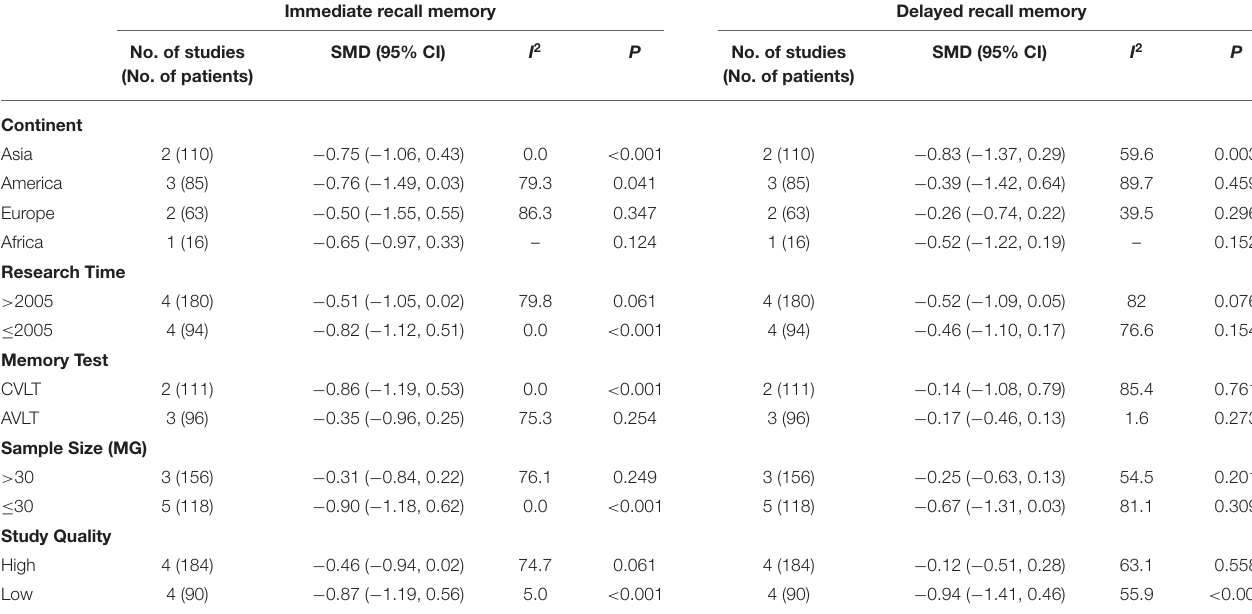
TABLE 4 | Effect of study characters on the